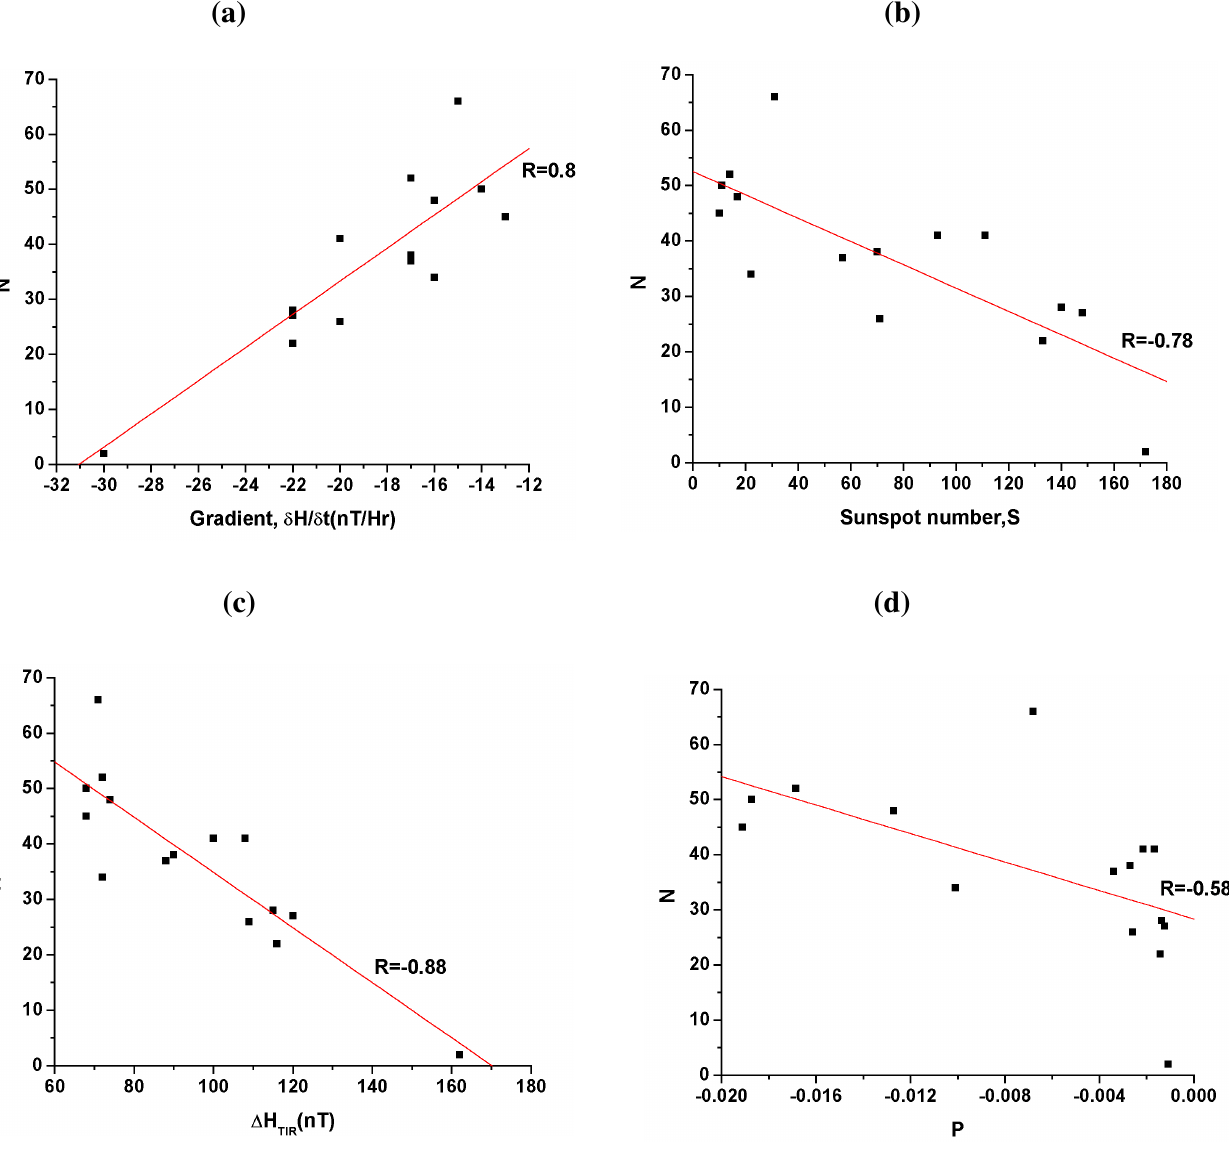
Fig. 7. Graphical representation of the relationship between the number of days of E sb events (N) and (a) average gradient, δH sunspot number, S, (c) average noontime maximum 1 H TIR , (d) the factor P for each year during